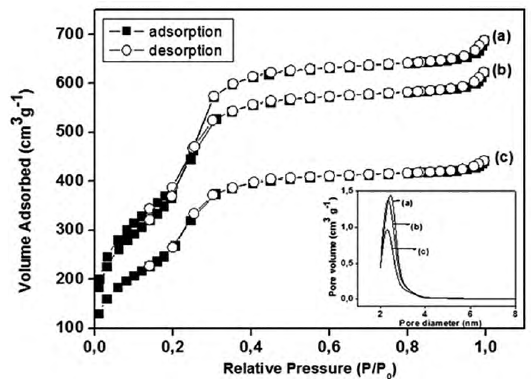
adsorption-desorption isotherms at 77K and BHJ Figure 2. N 2 pore size distribution curves of (a) MCM-41, (b) Al-MCM-41(50), (c) Al-MCM-41(15).